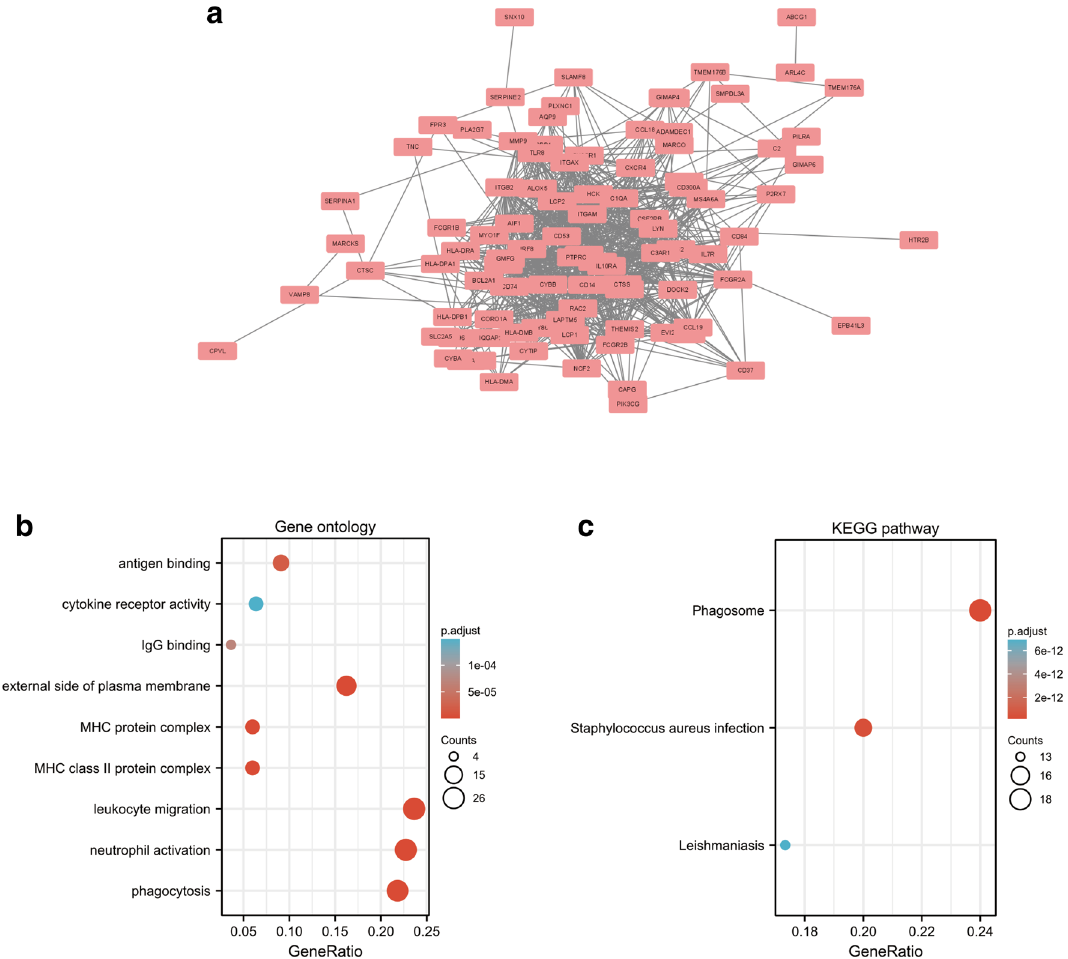
Figure 1. PPI network and functional enrichment of DEGs. ( a ) The interaction network between proteins coded by DEGs. ( b ) The enrichment analysis results of GO and ( c ) KEGG (www. kegg. jp/ kegg/ kegg1. html) pathway. Adjusted P value < 0.05 was considered